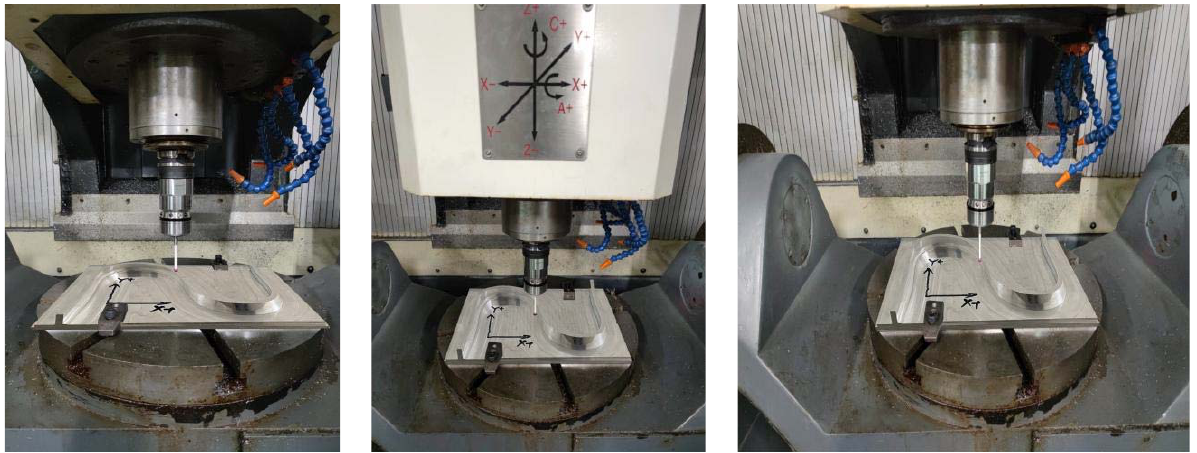
Figure 7. In the field of machine measurement.